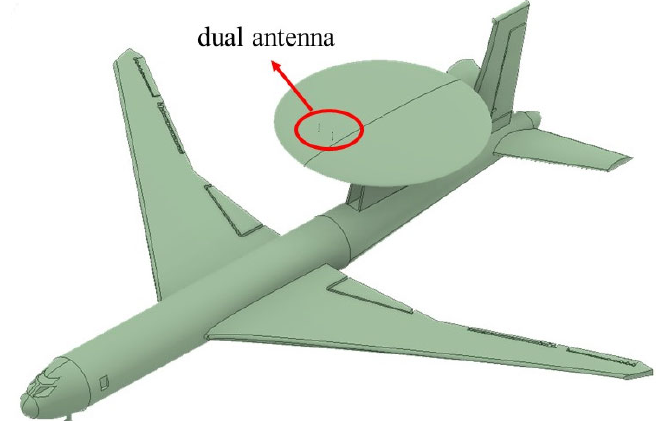
Figure 9. 3D ‐ model of the aircraft with the dual antenna structure. Figure 9. 3D-model of the aircraft with the dual antenna